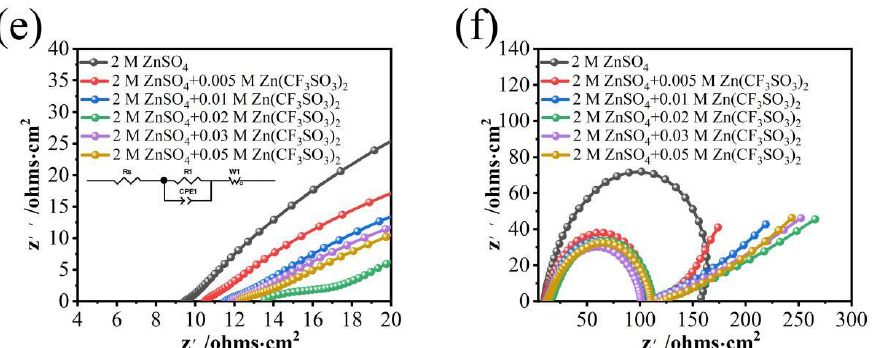
Figure 5. ( a ) Comparison of five CV curves (5 mV s − 1 ); ( b ) Numbers 1, 2, 3, 4, and 5 are 2 M ZnSO 4 + 0.005 M Zn(CF 3 SO 3 ) 2 , 2 M ZnSO 4 + 0.01 M Zn(CF 3 SO 3 ) 2 , 2 M ZnSO 4 + 0.02 M Zn(CF 3 SO 3 ) 2 , 2 M ZnSO 4 + 0.03 M Zn(CF 3 SO 3 ) 2 , and 2 M ZnSO 4 + 0.05 M Zn(CF 3 SO 3 ) 2 electrolytes, respectively; ( c ) Cycling performance (1 A g − 1 ) of hybrid anionic electrolyte; ( d ) Cycling performance (5 A g − 1 ) of electrolyte with the same Zn 2+ concentration; ( e ) Nyquist plot of hybrid anionic electrolyte in high-frequency region; ( f ) Nyquist plot of hybrid anionic